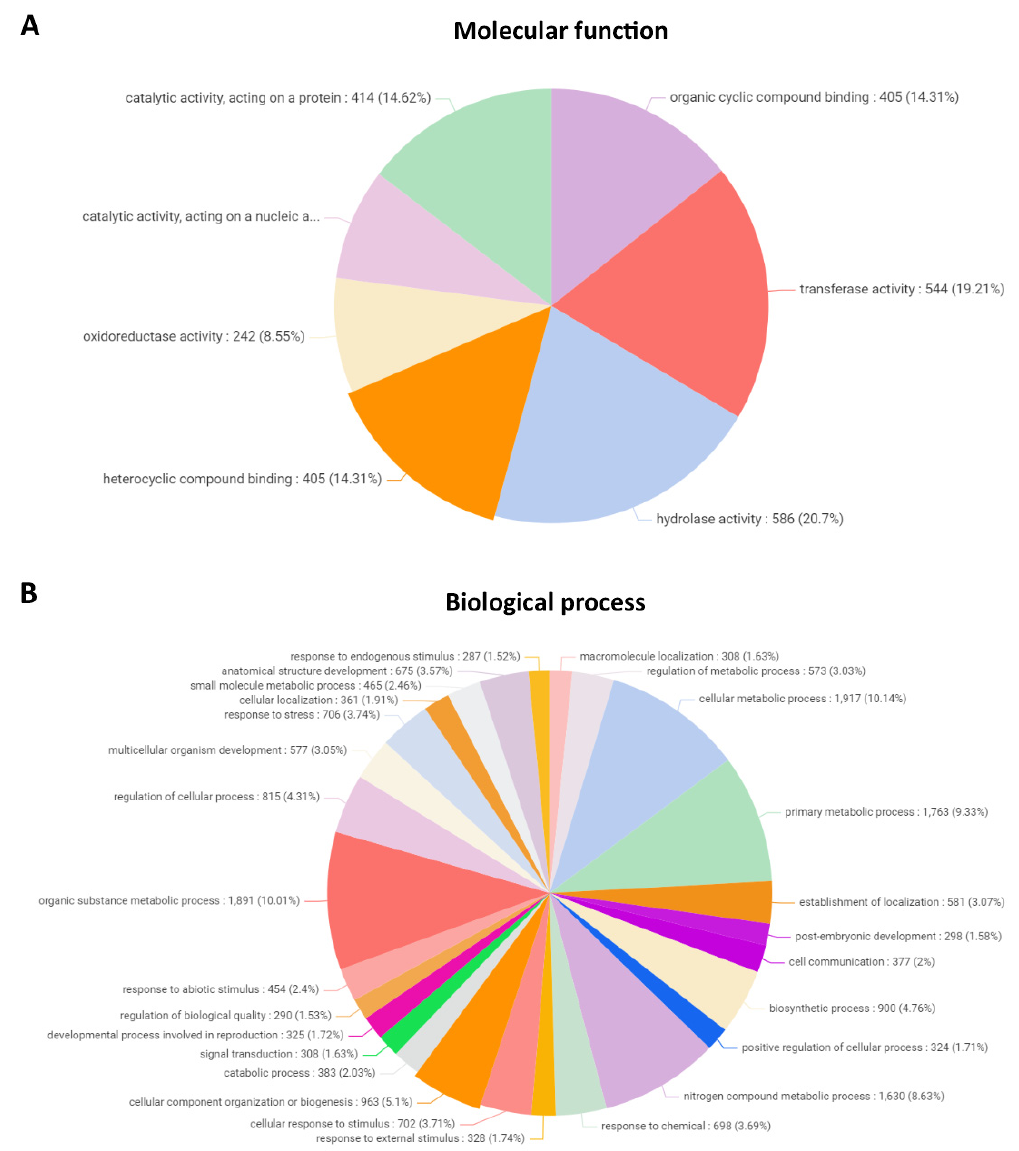
Figure 1. Classification into molecular function ( A ) and biological process (gene ontology) ( B ) of protein-coding genes in the genome of U. compressa.